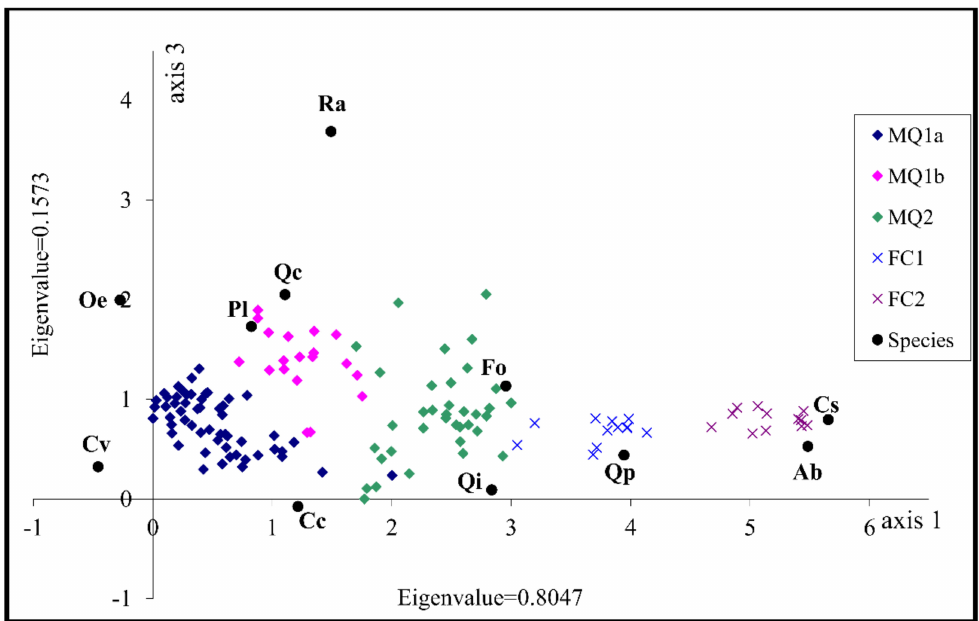
Figure 5. DCA samples-species ordination diagram for axes 1 and 3. For species codes see Figure 4. The first axis mainly summarises the intercommunity variation since the communi- ties and sub-communities occupy distinctive parts along the axis while the second axis appears to be representing an environmental gradient responsible for the floristic variation observed within the two forest communities. The third axis represents an environmen- tal gradient responsible for the intercommunity variation between the sub-communities MQ1a and MQ1b as well as the intracommunity variation in those two sub communities and in the MQ2 community. At the same time the third axis has a minimum effect on the intracommunity variation of the two forest communities. Given that